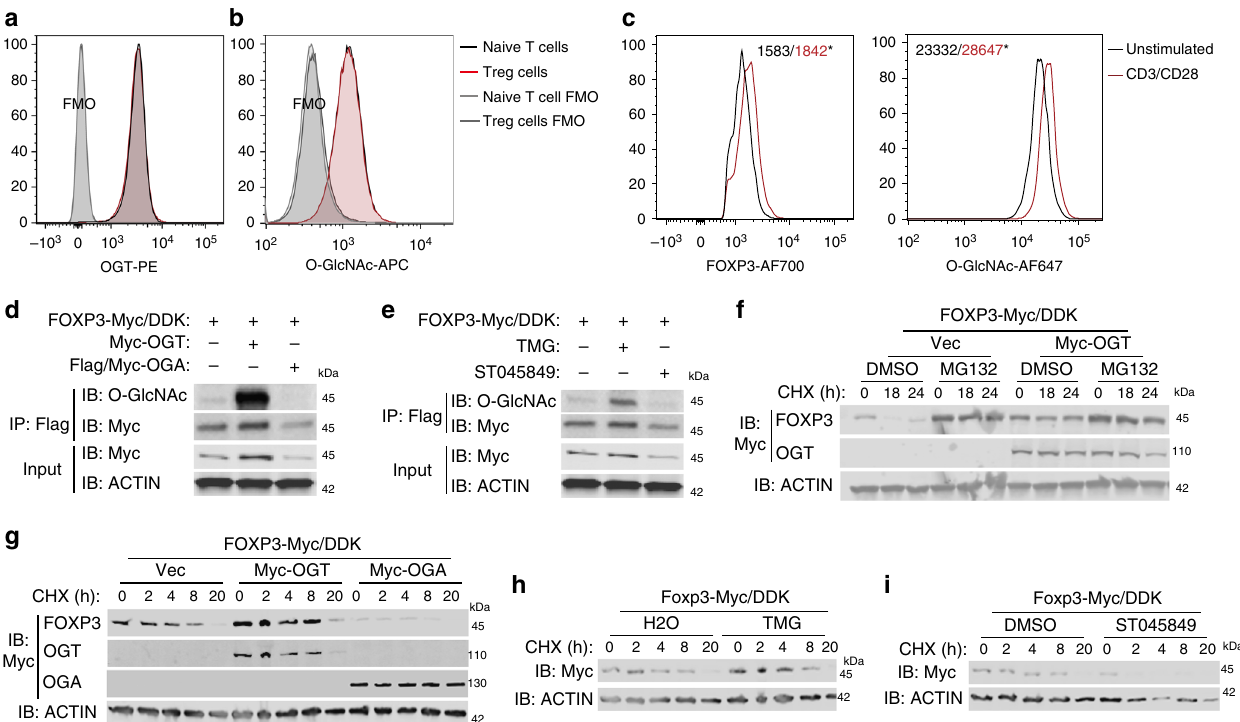
Fig. 1 O-GlcNAc-cycling enzymes regulate FOXP3 stability in vitro. a , b Mean fl uorescence intensity (MFI) of OGT ( a ) and O-GlcNAcylation ( b ) in CD4 + CD25 − naïve T cells, CD4 + CD25 + FOXP3 + Treg cells and corresponding Fluorescence Minus One (FMO) negative controls. c Treg cells isolated from wildtype mice were stimulated with or without anti-CD3/CD28 beads for 24 h ex vivo ( n = 3). MFI of FOXP3 and O-GlcNAcylation was analyzed in CD4 + CD25 + FOXP3 + Treg cells. d , e HEK 293 cells were transfected FOXP3 together with OGT or OGA ( d ) or treated with inhibitors of OGT (ST045849) or OGA (TMG) ( e ). FOXP3 O-GlcNAcylation was determined by immunoprecipitation followed by western blotting. f FOXP3 stability was determined by treatment of cycloheximide (CHX) in combination with MG132 with or without OGT overexpression, DMSO was used as a control for MG132. g – i FOXP3 stability was determined in the presence of OGT/OGA overexpression ( g ), TMG ( h ), or ST045849 ( i ). Data are shown